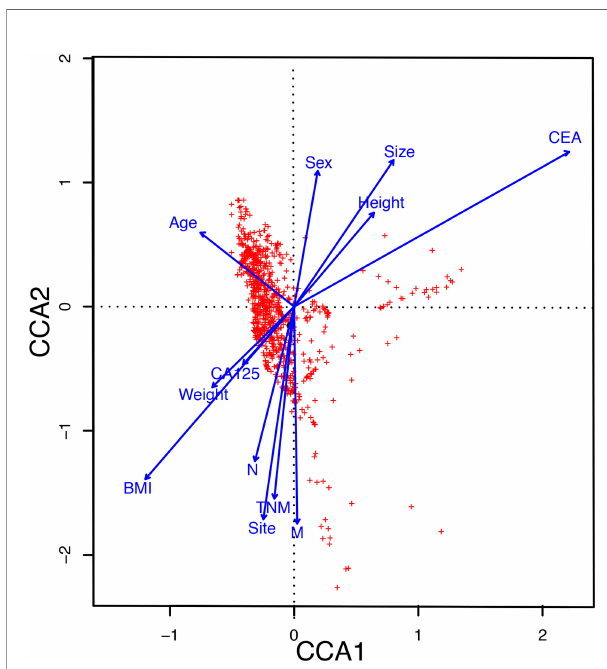
FIGURE 3 | The CCA analysis revealed the in fl uence of clinical parameters on the distribution and structure of the gut microbiome. CCA, The canonical correspondence analysis; CEA, Carcinoembryonic antigen; BMI, Body Mass